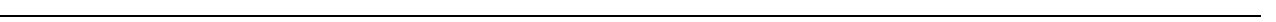
Fig. 1 An in vivo genetic screen identi fi es OTUD1 as potent suppressor of breast cancer metastasis. a , b Flow chart and fi gures of the in vivo screen identifying DUBs that inhibit breast cancer metastasis. Low metastatic MDA-MB-231-Luciferase/GFP breast cancer cells were infected with lentiviruses expressing DUB shRNAs and intracardially injected into nude mice. The mice were monitored for 4 weeks by in vivo bioluminescent imaging (BLI) and the early metastatic nodules were isolated and the corresponding shRNAs were identi fi ed by sequencing. See Supplementary Fig. 1a for details. c Immunoblot (IB) analysis of OTUD1 shRNA and sgRNA-mediated knockdown and knockout in MDA-MB-231 (BM) cells. d IB analysis of MDA-MB-231 (BM) cells stably expressing doxycycline (dox)-inducible OTUD1 and treated with the indicated doses of Dox. e Left panel: BLI of three representative mice injected with MDA-MB-231 control cells or cells de fi cient in OTUD1, Images were taken 4 weeks after injection. Two independent sgRNAs were used to generate OTUD1 knockout cells. Right upper panel: BLI signals of all mice in each experimental group at week 5. Right lower panel: The percentage of metastasis-free mice in each experimental group followed in time. f MDA-MB-231 cells expressing DOX-inducible OTUD1-wt/CA was intracardially injected in mice. DOX was administrated 21 days after inoculation of the cells. Metastasis was analyzed by BLI. Left panel: BLI of representative mice from each group at indicated days. Right upper panel: BLI signal of each experimental group followed in time. Right lower panel: The percentage of metastasis-free mice in each experimental group followed in time. g Oncomine database summary for OTUD1 expression in multiple cancers (left). Box plots of OTUD1 expression levels in invasive ductal breast carcinoma (IDBC) and lung adenocarcinoma (LA) compared with normal tissue (right). h Kaplan – Meier analysis of relapse-free survival of patients in publicly available breast cancer datasets (NKI 295). i BRCA1 target genes are enriched in OTUD1 -high versus OTUD1 -low expressing patients shown by pre-ranked gene-set enrichment analysis (GSEA). * p < 0.05, ** p < 0.01 and *** p < 0.001 (two-tailed Student ′ s t -test ( e , f ), Log-rank test ( h ) or two-way analysis of variance (ANOVA) ( e , f